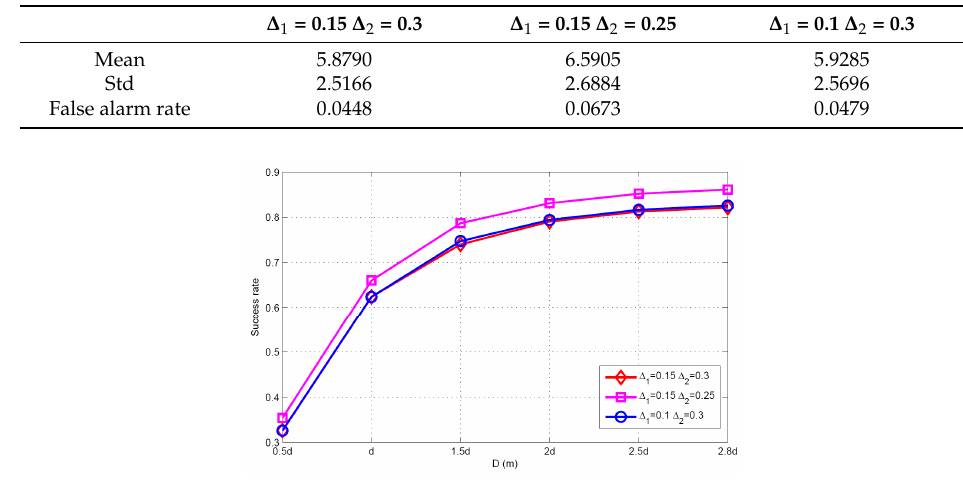
Figure 3. Success rate versus different thresholds.